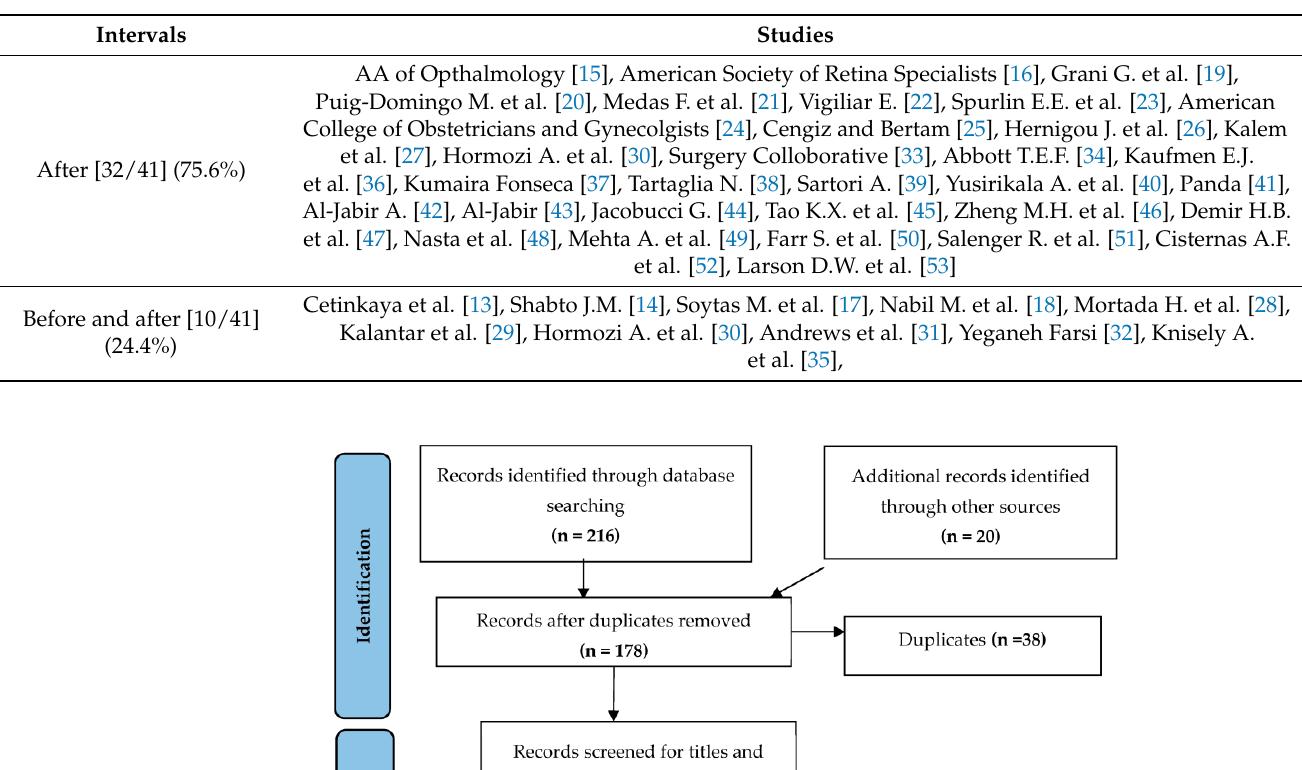
Table 2. Intervals of the studies conducted.